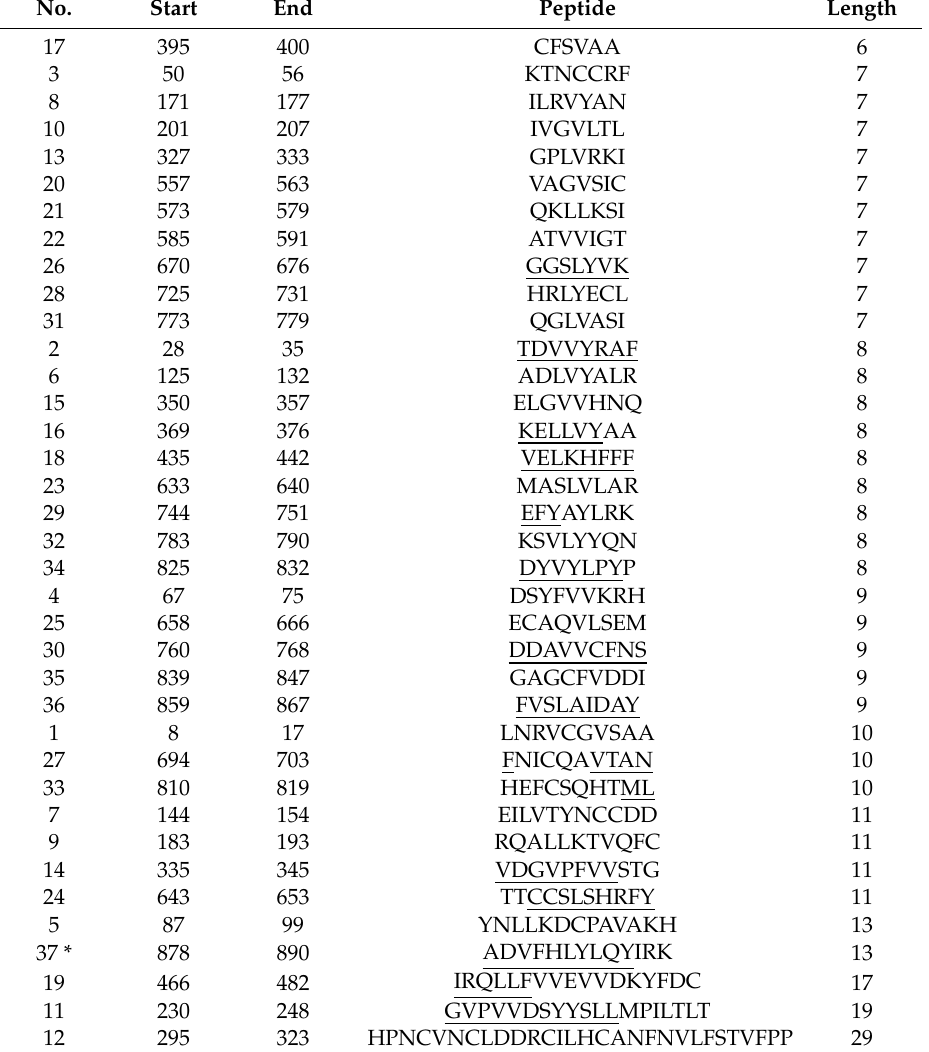
Table 2. Predicted antigenic B-cell epitopes of SARS-CoV-2 Nsp12 RNA